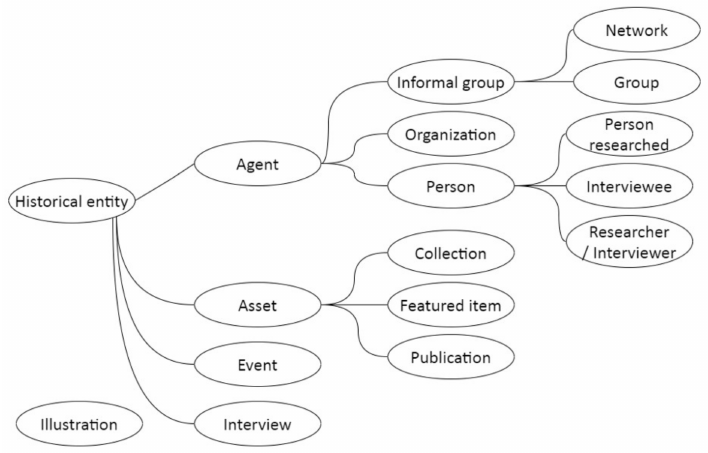
Figure 2. The main types of the COURAGE